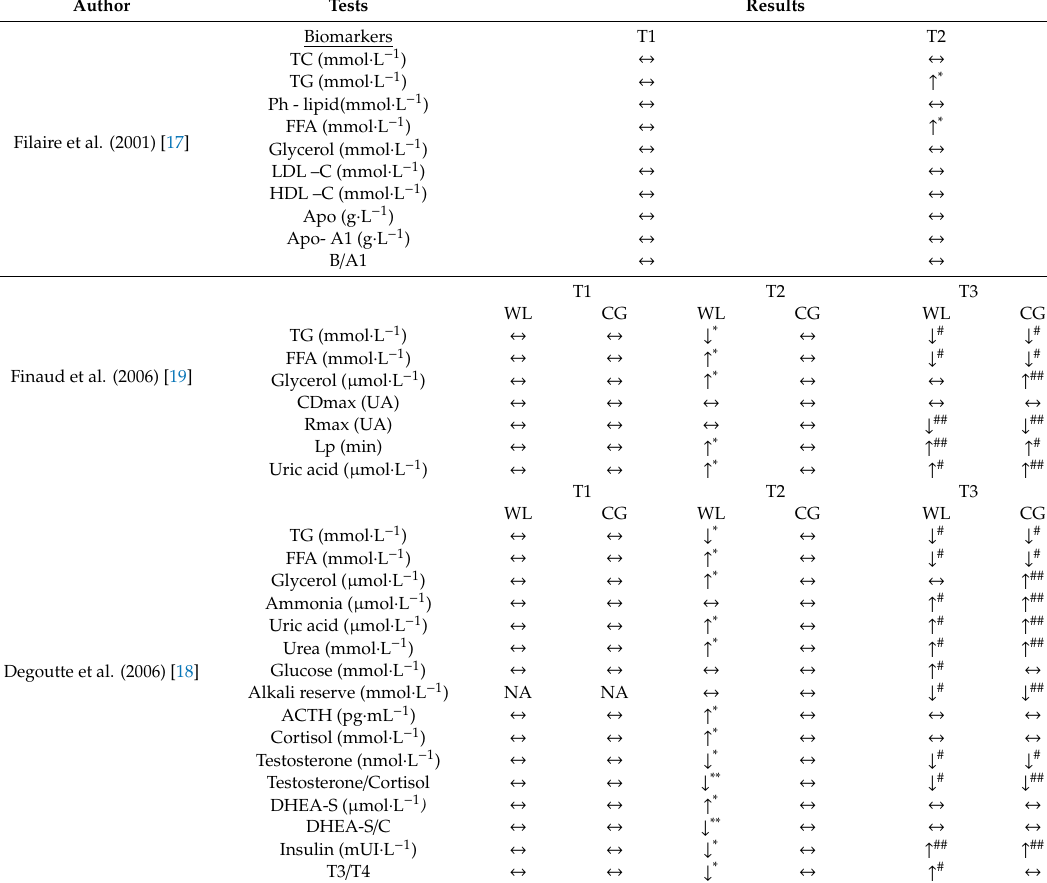
Table 3. E ff ects of rapid weight loss on